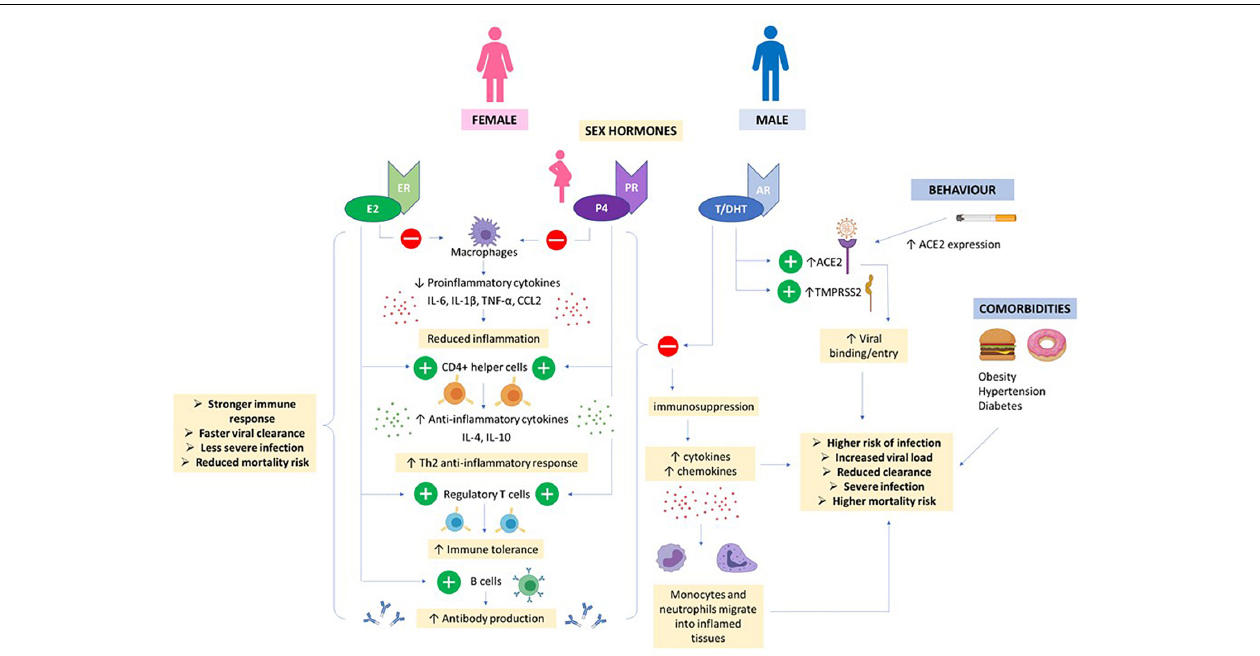
FIGURE 5 | Hormones and COVID19. High E2 and P4 concentrations in females (even higher in pregnancy) helps to suppress proinflammatory cytokine production by macrophages and prevent migration of monocytes and neutrophils into inflamed tissues. CD4 + helper cells are stimulated to produce anti-inflammatory cytokines and T regulatory cells promote immune tolerance. E2 also stimulates production of antibodies. Together, this results in a stronger immune response, faster viral clearance and less severe COVID infection in women. Androgens e.g., T/DHT and AR signaling increases expression of ACE2 and TMPRSS2 promoting viral entry. Together, T/DHT’s immunosuppressive effects, male behavioral factors and co-morbidities can contribute to a more severe COVID infection and worse outcome in males.